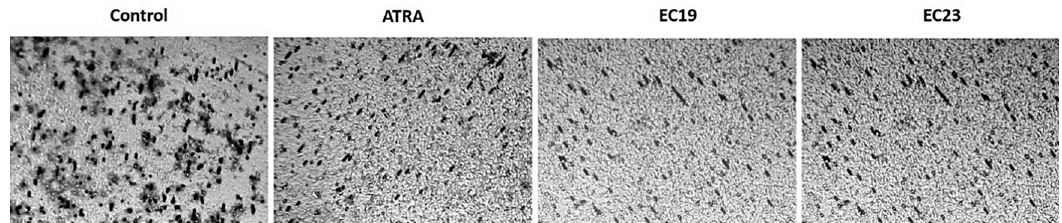
Figure 5. Transwell invasion assay shows the pattern of penetration of Caco-2 cells through the collagen matrix basement membrane. Cells were allowed to invade towards 10% fetal bovine serum for 48 h in the absence or presence of IC 50 dose of ATRA and EC-synthetic retinoids. The cells penetrating the membrane were stained with violet dye.